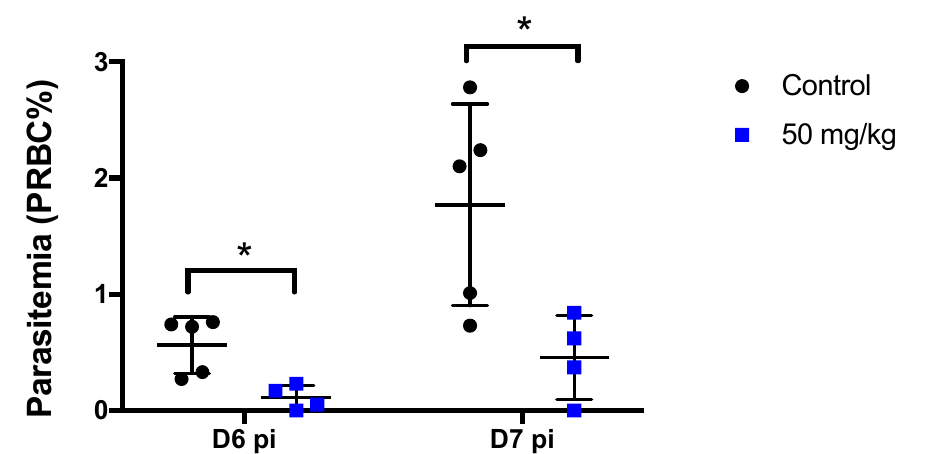
Figure 6. Single treatment of MB before challenge by mosquito bite reduces subsequent blood- stage parasitemia. Mice were first treated with MB (50 mg/kg) 30 min before the mosquito challenge and were then challenged by the bite of P. berghei -infected mosquitoes. Blood stage parasitemia of P. berghei was monitored in mice by studying Giemsa-stained blood smears on day 6 and day 7 after the infection by mosquito bite. Data are presented from one representative experiment. The black lines represent the mean and standard deviation. Asterisks (*) indicate significant ( p < 0.05) differences between each treatment group and control.